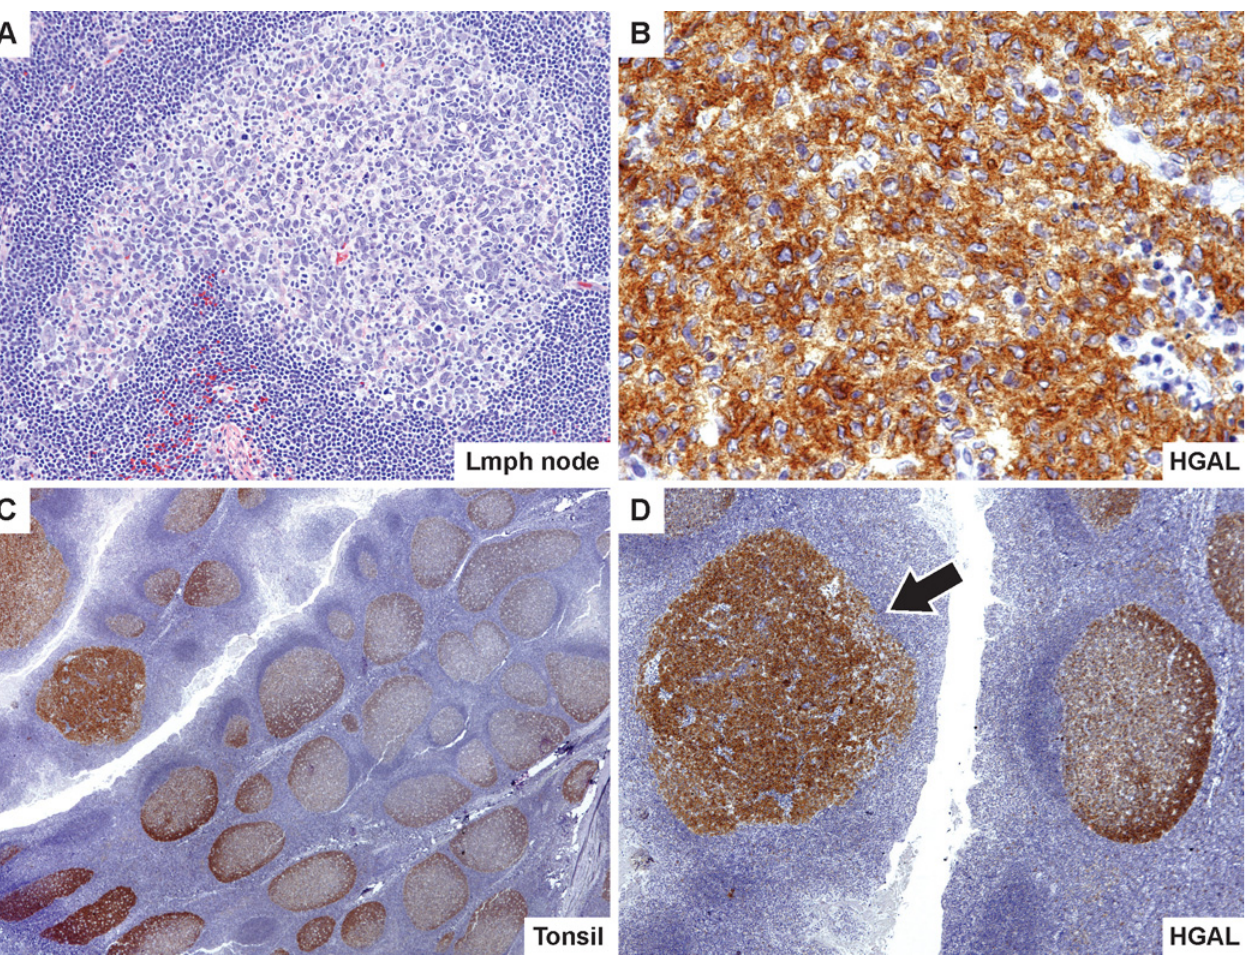
Fig 3. Atypical expression of HGAL in isolated atypical follicles. An axillary lymph node in a 53-year old woman (case 2) shows a single atypical follicle with pleomorphic large cells overexpressing HGAL (A and B). Sections of the tonsil in a 6-year old boy stained with HGAL, show preservation of overall architecture with numerous normal reactive follicles and a gradient of HGAL staining with higher intensity in the dark zone. In the atypical follicle (indicated by arrow in panel D), HGAL staining is abnormal and shows overexpression throughout the affected follicle (C and